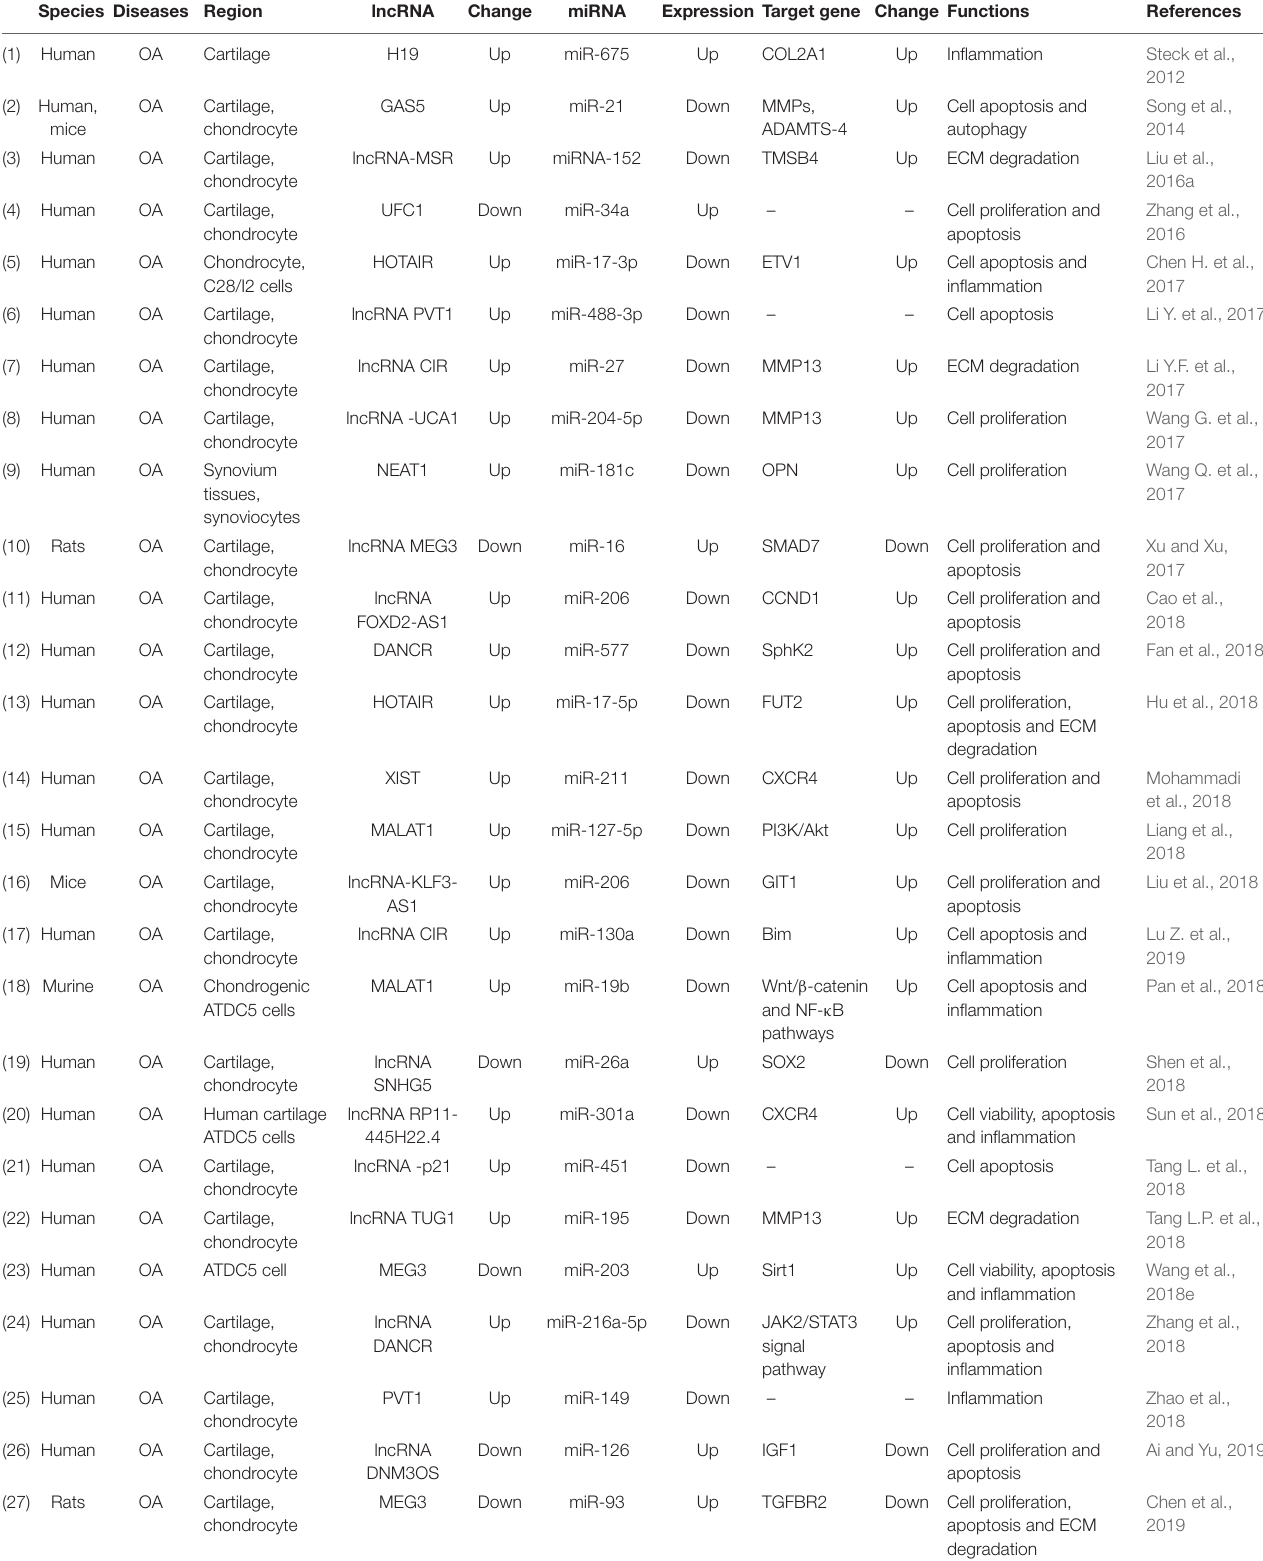
TABLE 1 | lncRNA/miRNA/mRNA networks in osteoarthritis. Species Diseases Region